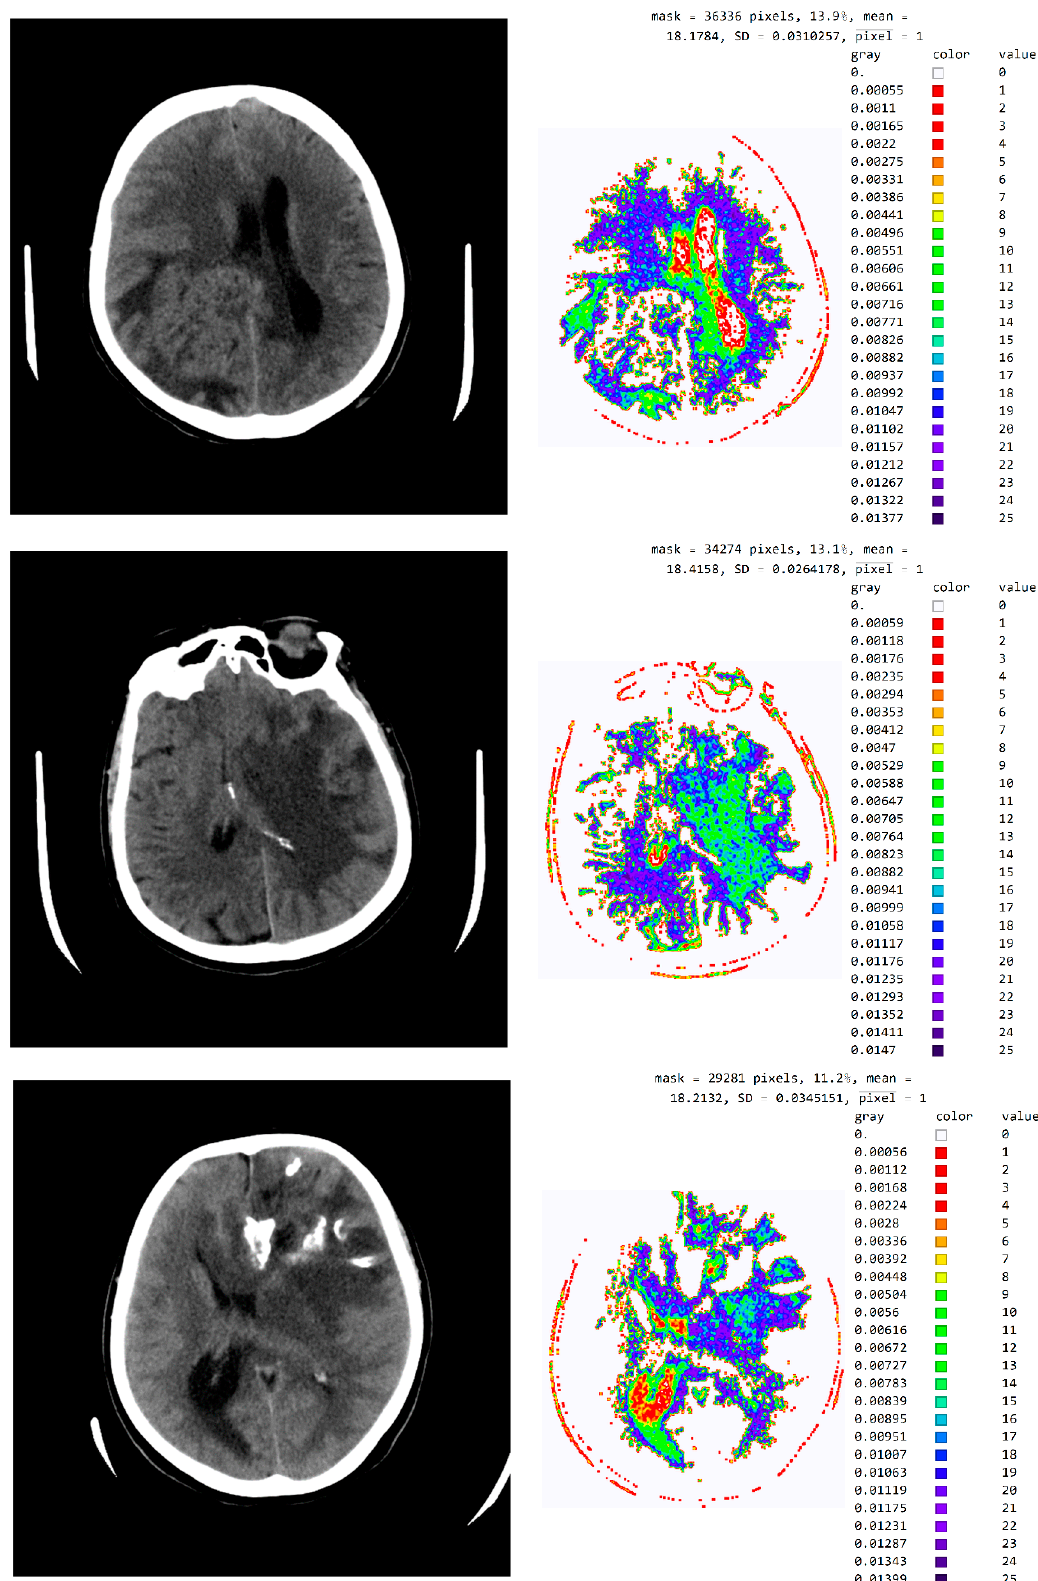
Figure A2. An image in gray levels with the averaged red part from processing. ( a ) An image dis- play in gray levels and ( b ) an image display with the red, averaged part added.